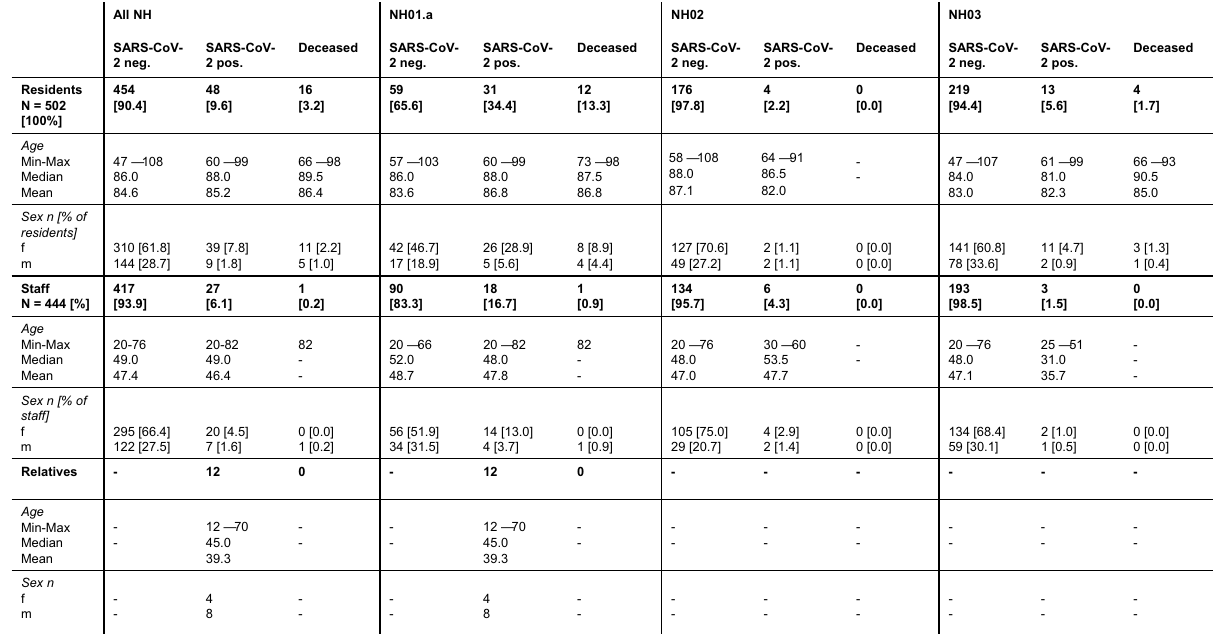
Figure 4. Characteristics of residents, staff members and relatives in three affected COVID-19 affected nursing homes. Data are given for all nursing homes (NH01-03) in summary as well as for each single nursing home. Data are given in (%), mean or median, unless stated